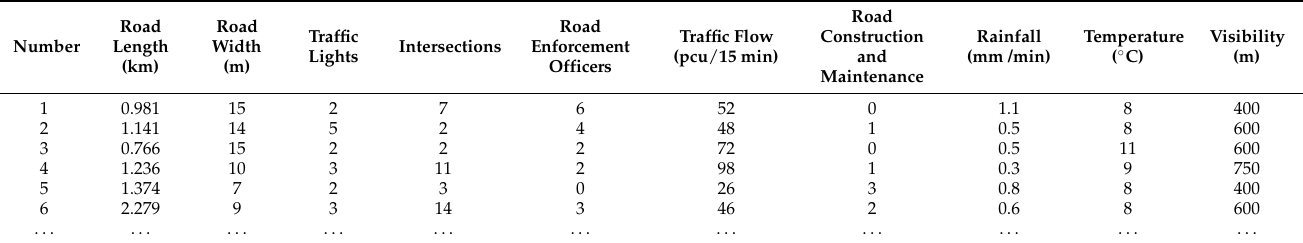
Table 5. Selected data from the traffic trend prediction